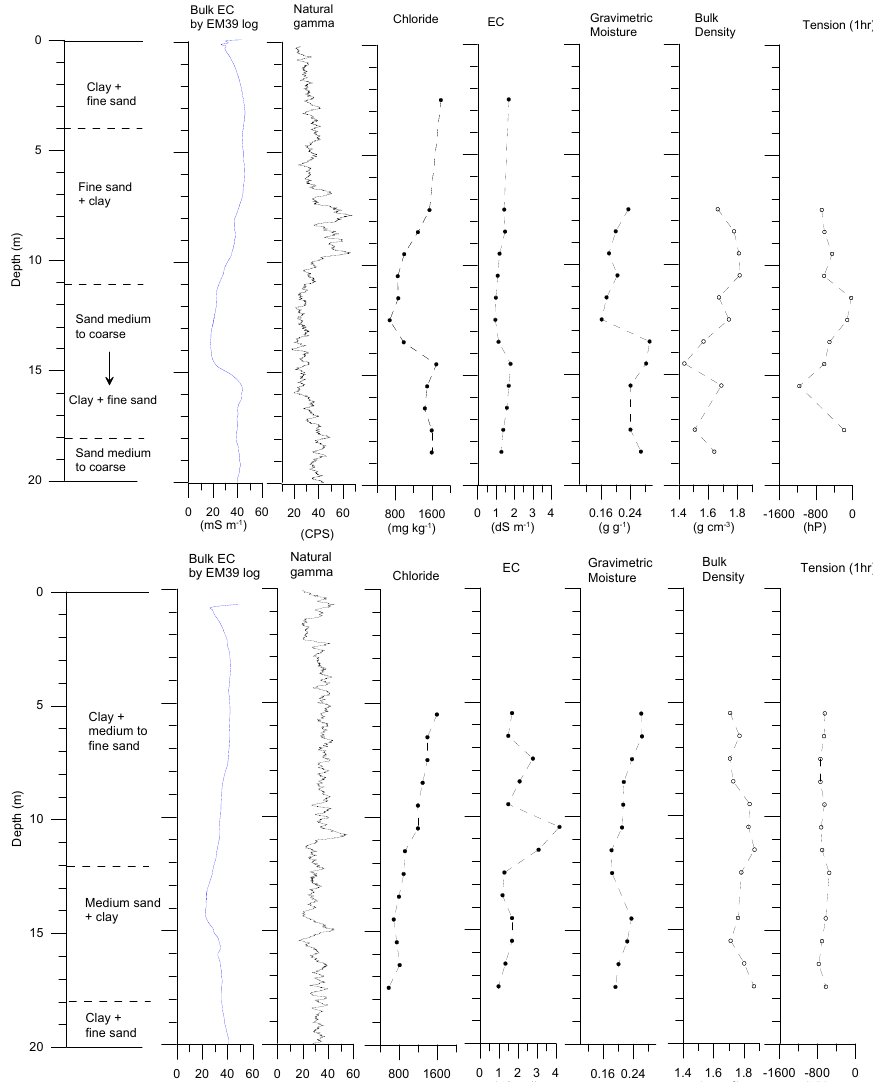
Fig. 5. Downhole sediment measurements showing bulk electrical conductivity and natural gamma logs, and core measurements including soil:water 1:5 electrical conductivity, chloride, water content, bulk density and tension for the (a) D1 site and (b) D3 site.